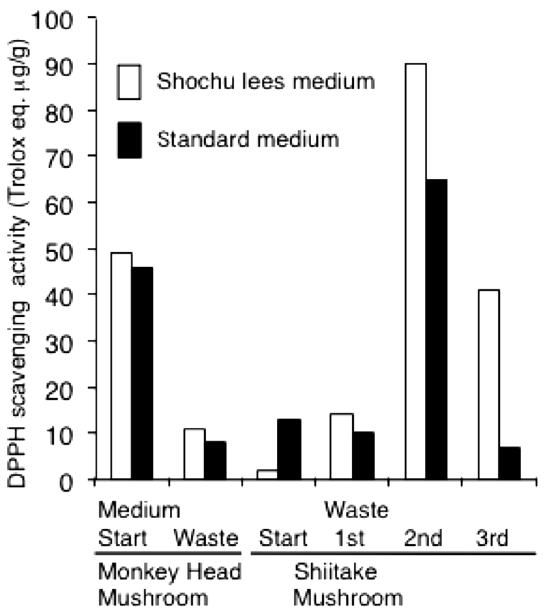
Fig. 1 DPPH scavenging activity of waste media. DPPH scavenging activity of waste and start media of monkey head mushroom and shii- take mushroom were measured. Shiitake mushroom 1st, 2nd, and 3rd are the waste media after 1st, 2nd, and 3rd harvest,